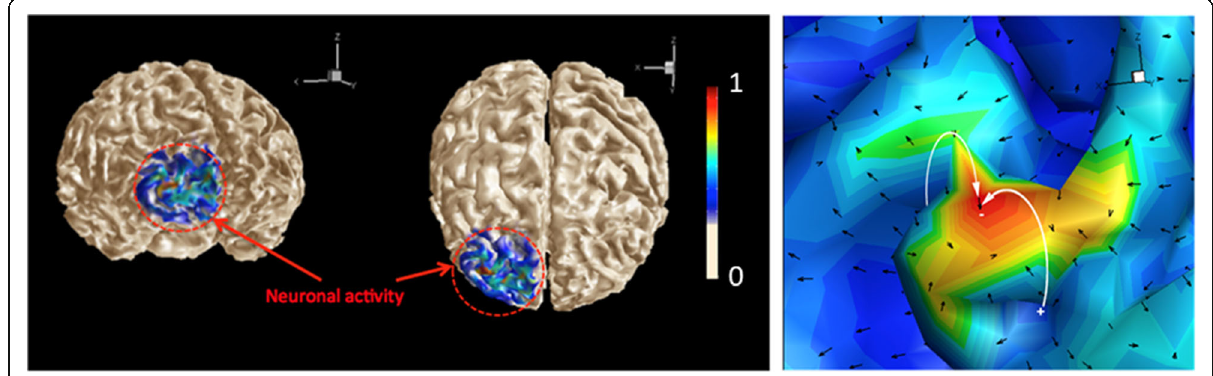
Fig. 4 Normalized De-modulated MPI-MEN/MPI-MN images of two different angle views of frontal lobes. (Right) The insert shows a detailed normalized 3D field profile in the region of